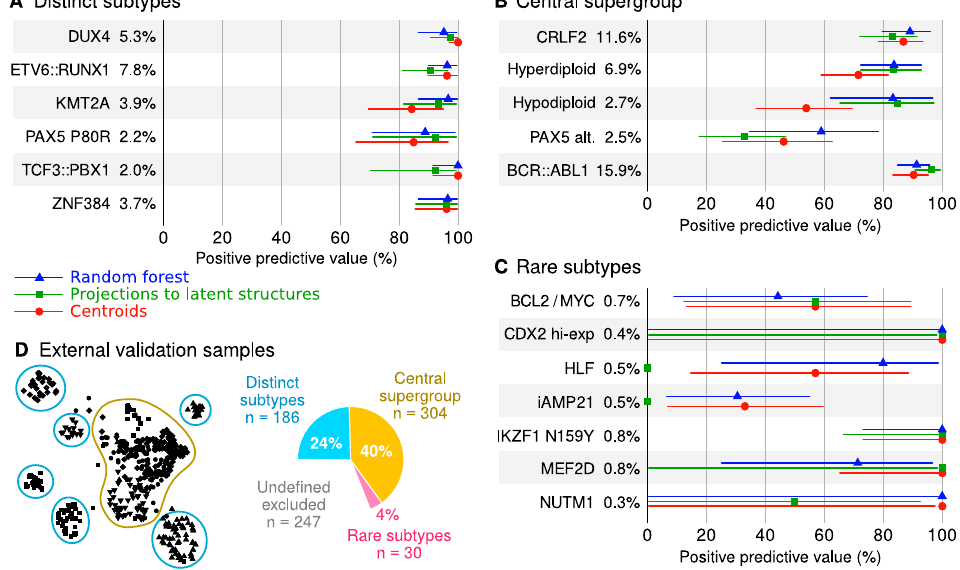
Figure 4. Comparison of three machine learning algorithms. Each model was fit to the batch-corrected North American data (training set n = 1078) and then evaluated in unadjusted Australian data (external validation set n = 520). Samples with undefined genetic subtypes were excluded from the analyses. ( A–C ) The forest plots show 95% confidence intervals that reflect the statistical uncertainty due to finite category sizes. The percentages written in the plots indicate the prevalence of the genetic subtype in the Australian dataset. ( D ) Description of subtype supergroups.